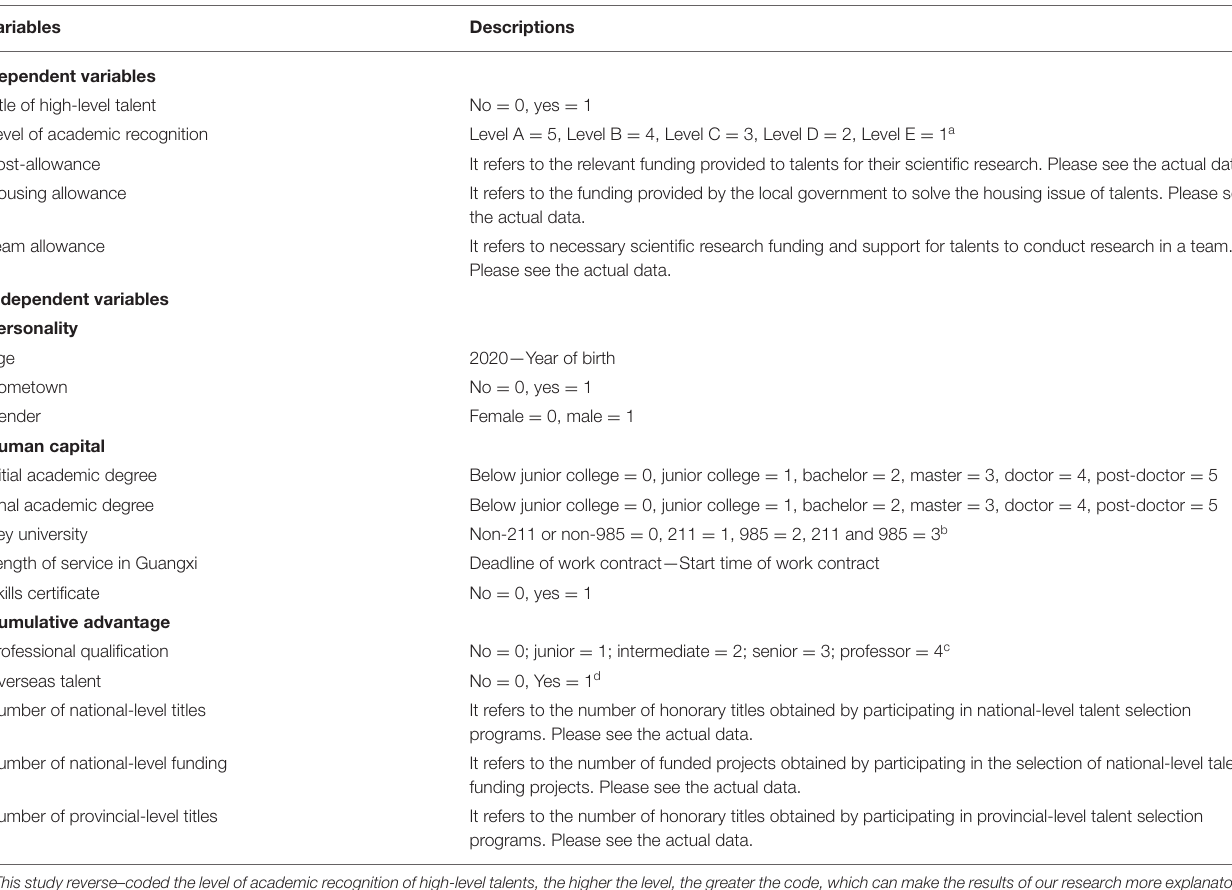
TABLE 1 | Value nd descriptive statistics of each